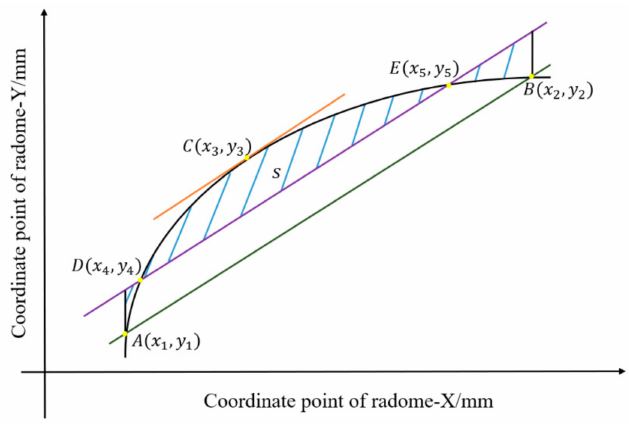
Figure 6. Corresponding point determination diagram.